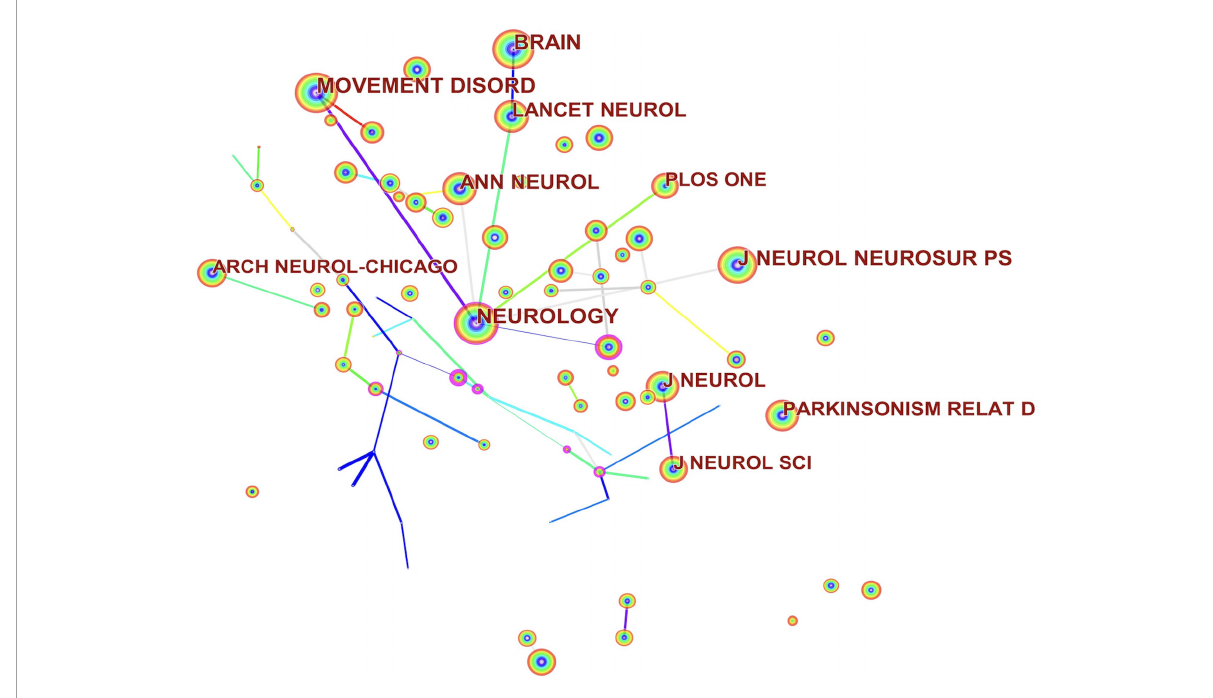
FIGURE5 Journal co-citation maps in the field of exercise for movement disorders research.